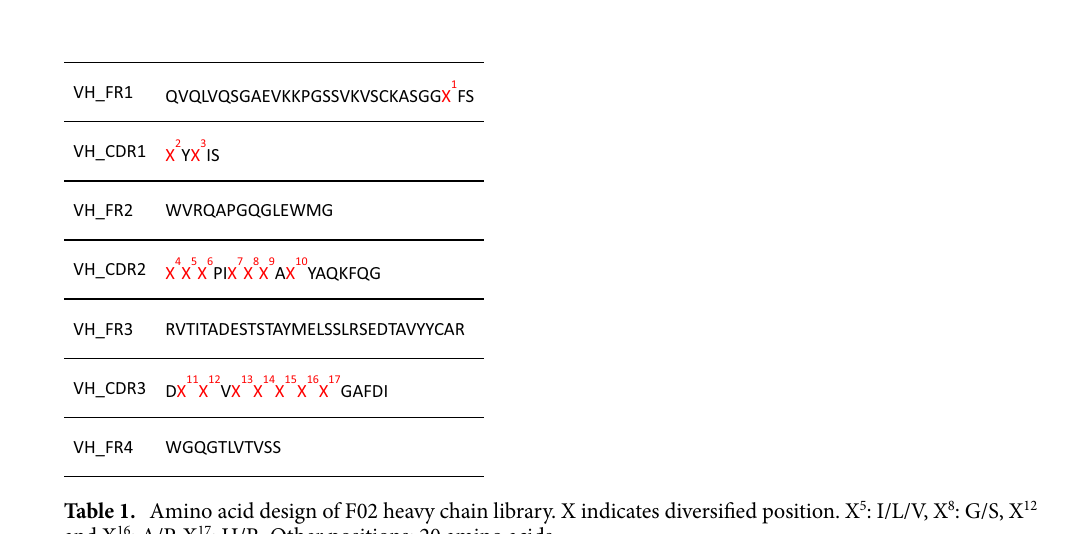
Figure 1. Overall workflow for our proposed LSTM based sequence generation and prioritization scheme.